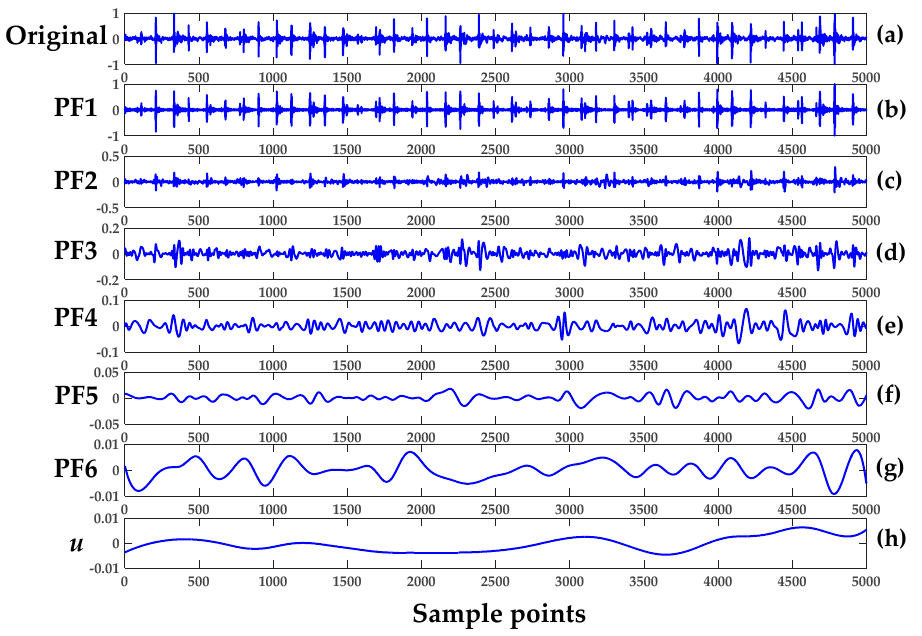
Figure 5. Product functions of the damage Case 1 set: ( a ) original (D3) vibrational signal; ( b ) PF1; ( c ) PF2; ( d ) PF3; ( e ) PF4; ( f ) PF5; ( g ) PF6; and ( h ) u is the residual signal.